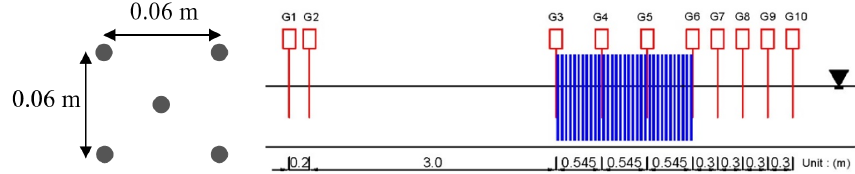
Figure 1. Cylinder cell arrangement (left), field length (right), and locations of wave probes for the computations.